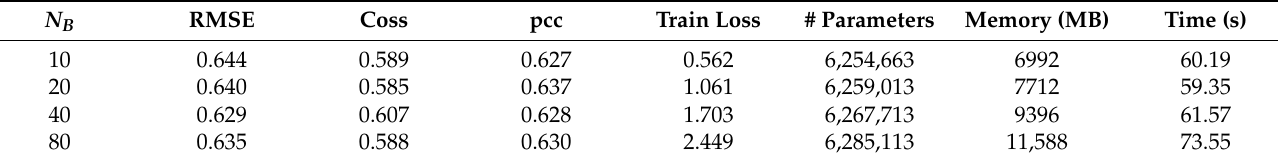
Figure 15. Appearance comparison of six EVC test patches across different bin counts, reconstructed using the weighted sum method. Table 6. Comparison of EVC performance metrics across different bin